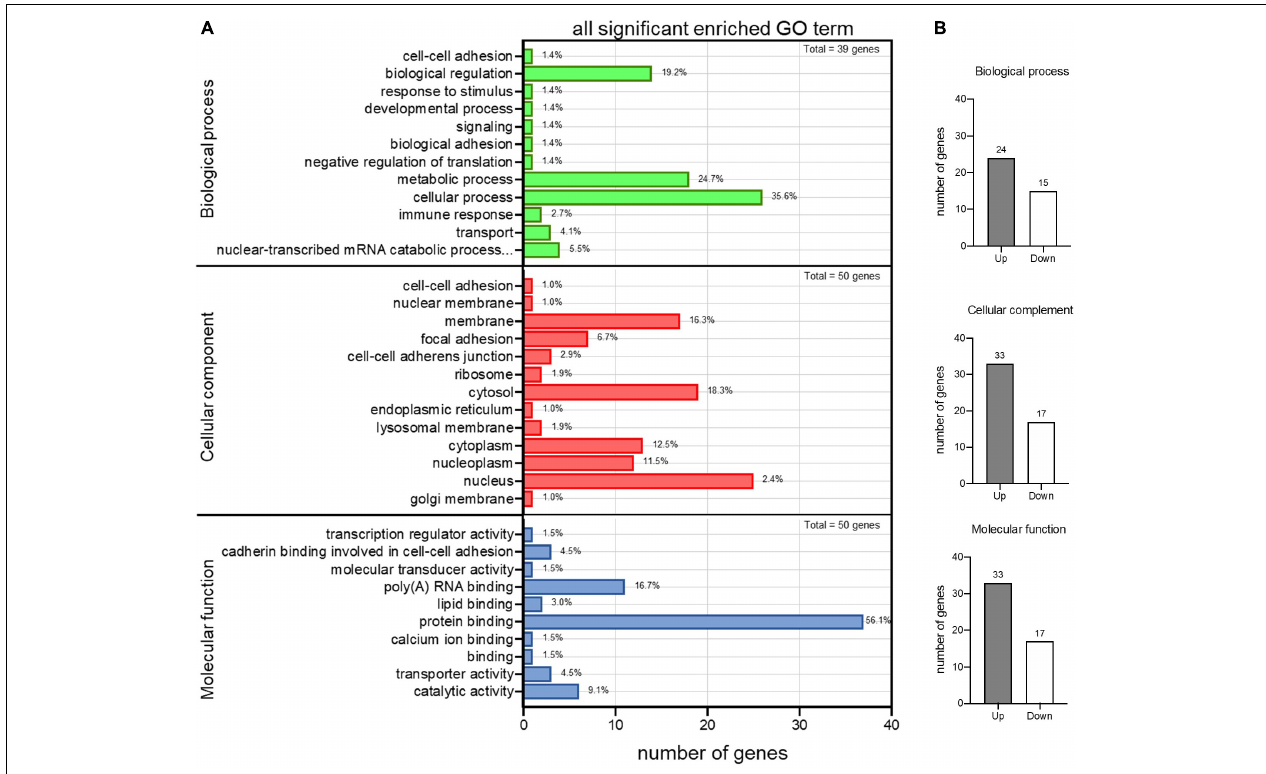
FIGURE 3 | Gene Ontology (GO) enrichment analysis of differential expression of 55 intersecting genes in the familial hyperlipidemia (FH) and familial coronary heart disease (FH-CHD) versus N groups. (A) The ordinate represents the next level GO term of the three categories including biological process (upper panel), cellular component (middle panel), and molecular functions (lower panel). The abscissa represents the gene number under the term. (B) Bar graphs show number of upregulated (gray bar) and downregulated (white bar) genes in each category.